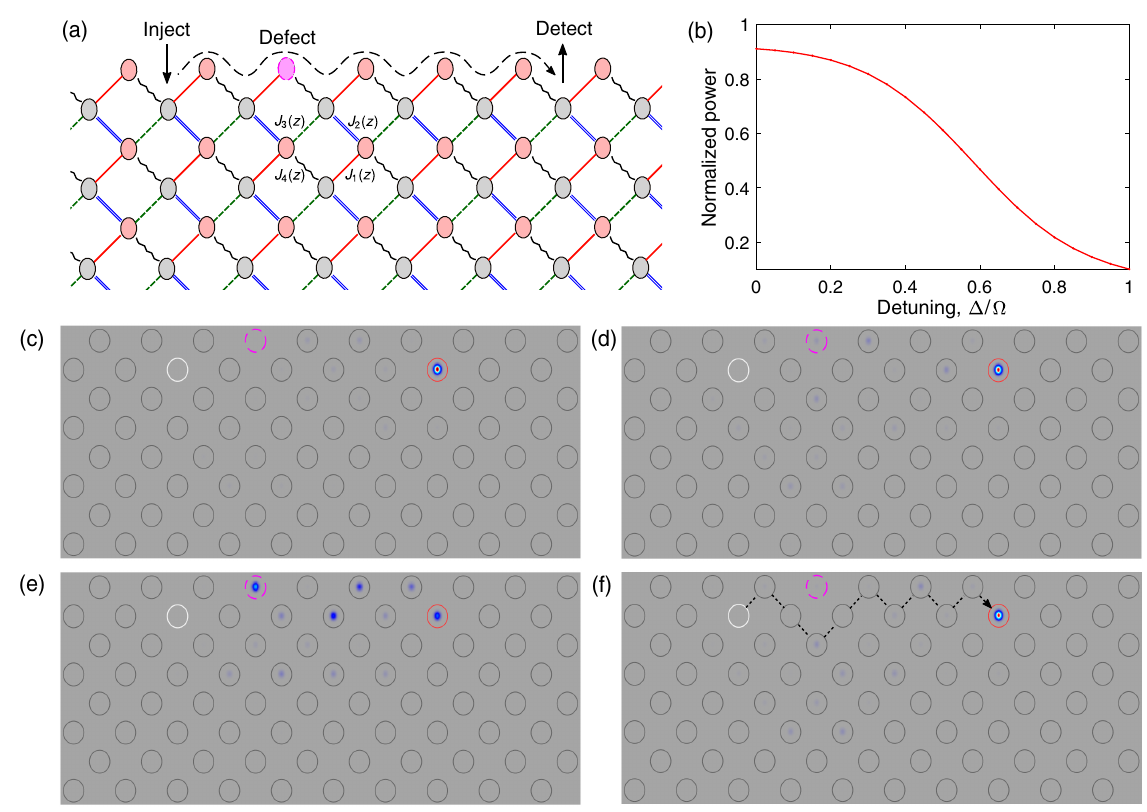
FIG. 9. A single defect on the edge. (a) Schematic of the driven square lattice discussed in the main text with δ ¼ 0 . 18 and a detuned site indicated by the magenta color. The nonlinear solitonlike state is injected at a single site (indicated by an arrow) and then detected after the state travels through a defect site. (b) Normalized peak power detected after propagation of z ¼ 5 z 0 as a function of the detuning of the on-site energy of the defect site. (c) – (e) Output intensity pattern associated with (b) for three different detunings Δ = Ω ¼ 0 , 0.3, and 0.8, respectively. For zero or small disorder [i.e., (c) and (d), respectively], the solitonlike state propagates unidirectionally with minimal radiation. For a comparatively larger disorder Δ = Ω ¼ 0 . 8 , the solitonlike state falls apart as shown in (e). (f) For an extensive detuning Δ = Ω ¼ 20 , the nonlinear state travels around the defect site — this is similar to the situation wherein the defect site is removed. The white circle indicates the site at which light is injected at the